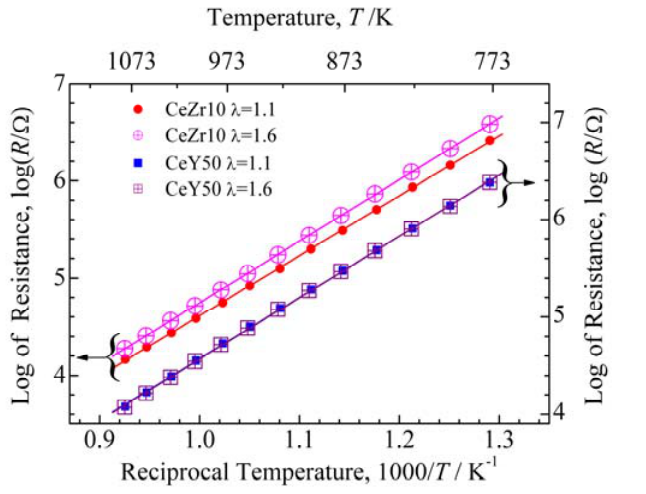
Zr O ) on the sensor element shown in Figure 5(b). 0.9 0.1 2